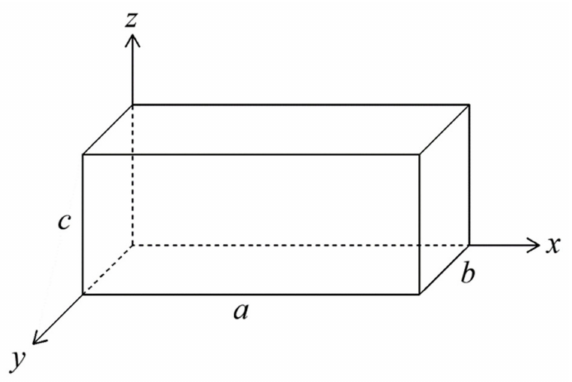
Figure 1. Schematic diagram of the rectangular microwave